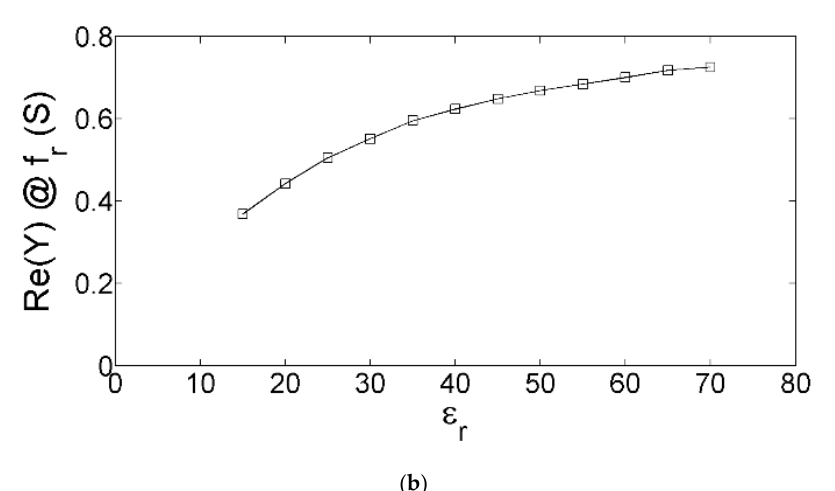
Figure 4. Behavior of the ( a ) resonant frequency and corresponding ( b ) peak in Re( Y ) versus ε r for the lossless MUTs placed on top of the sensing area of the IDC sensor.